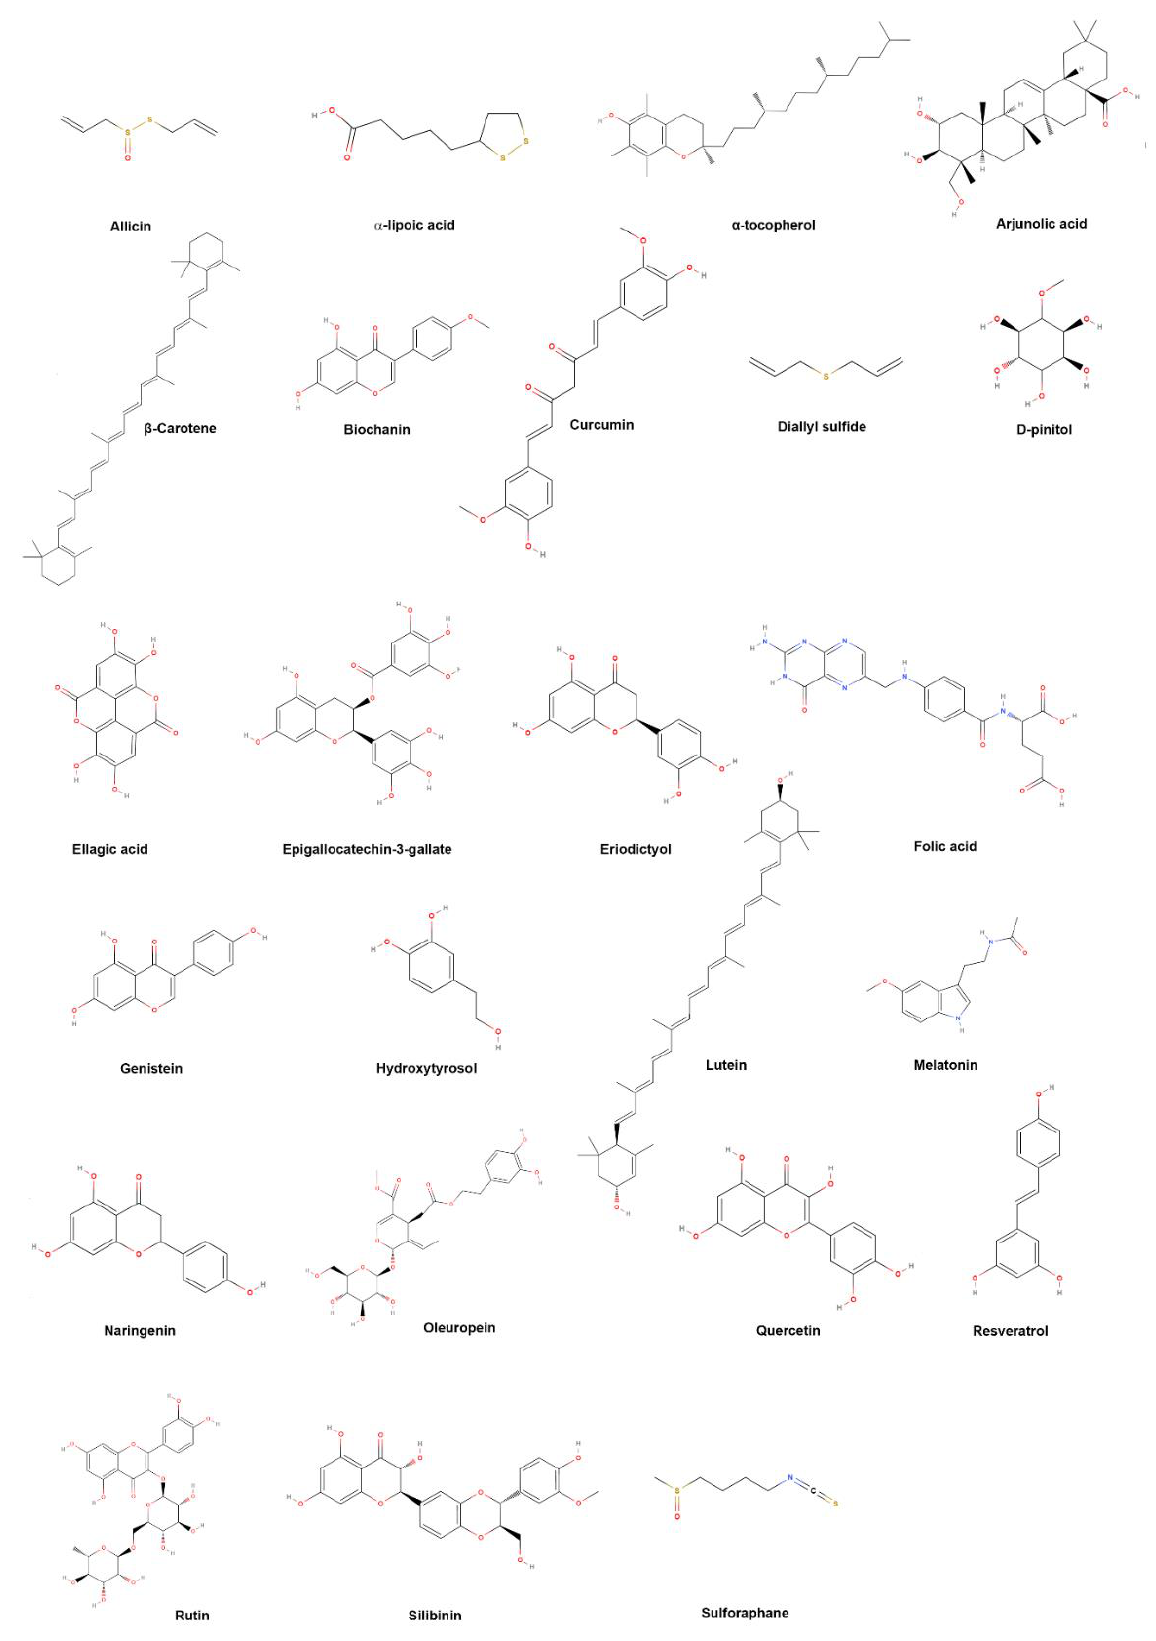
Figure 3. Chemical structures of the compounds active in alleviating arsenic toxicity.